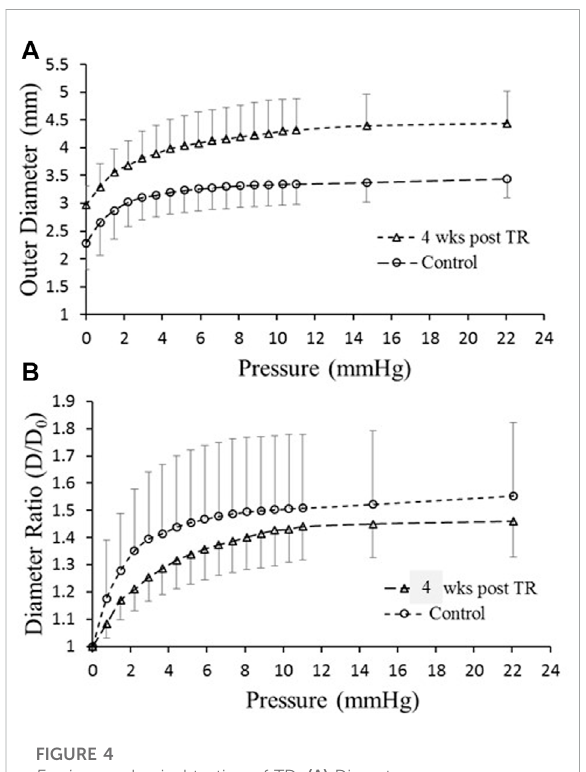
FIGURE 4 Ex vivo mechanical testing of TD. (A) Diameter versus pressure relationship for control and 28 days post-TR surgery. (B) Diameter ratio (degree of stretch) versus pressure for control and 28 days post-TR